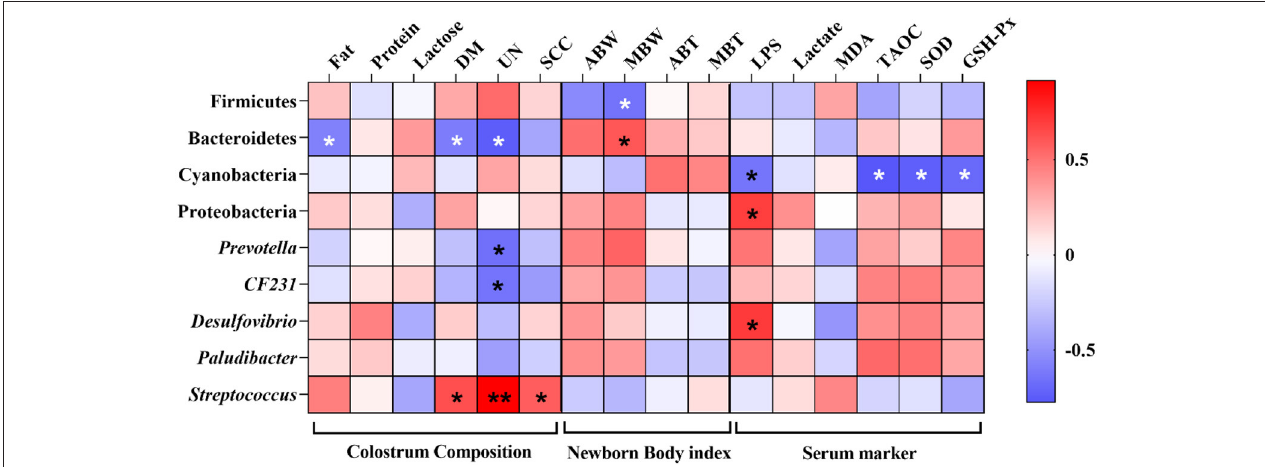
FIGURE 9 | Heatmap of the Spearman’s r correlations between the gut microbiota significantly modified by different diets treatment and colostrum composition, newborn body index of piglets, and serum marker of sows. ABW, average body weight; MBW, median body weight; ABT, average body temperature; MBT, median body temperature. Significance and correlation coefficient was analyzed by Spearman’s correlation analysis. * P < 0.05; ** P <